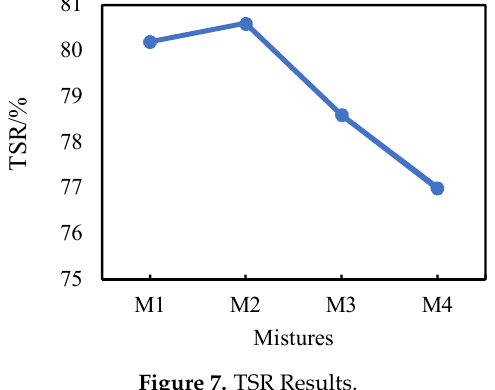
Figure 6. RMS Results.